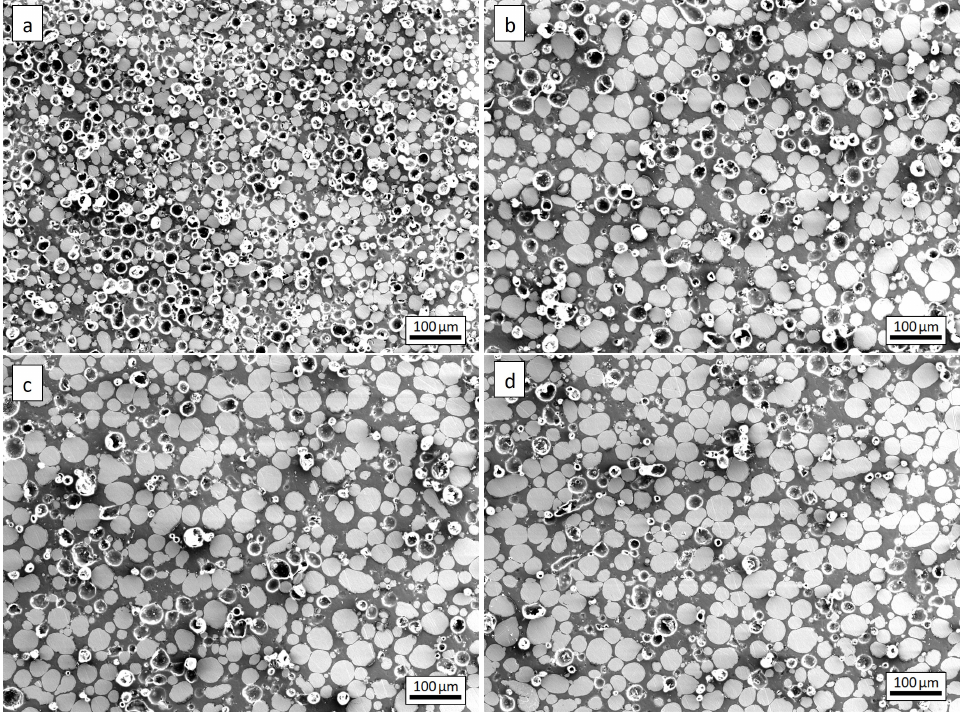
Figure 6. Microstructure of green body compacted under G = 3700 at radial positions of ( a ) 0.2, ( b ) 0.4, ( c ) 0.6, and ( d )